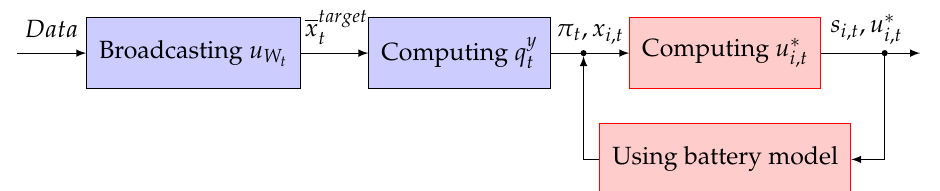
Figure 1. Block diagram of the MFG inverse Nash algorithm of BEV i at time t